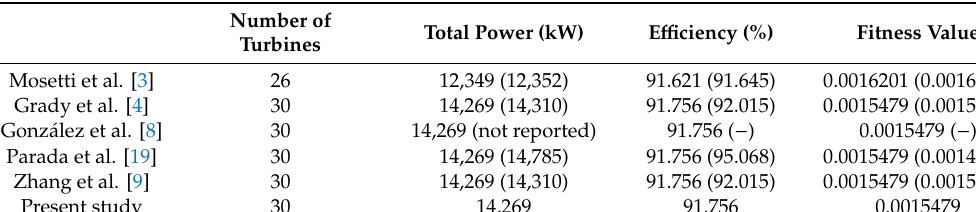
Figure 5. Layout results for case study (a).